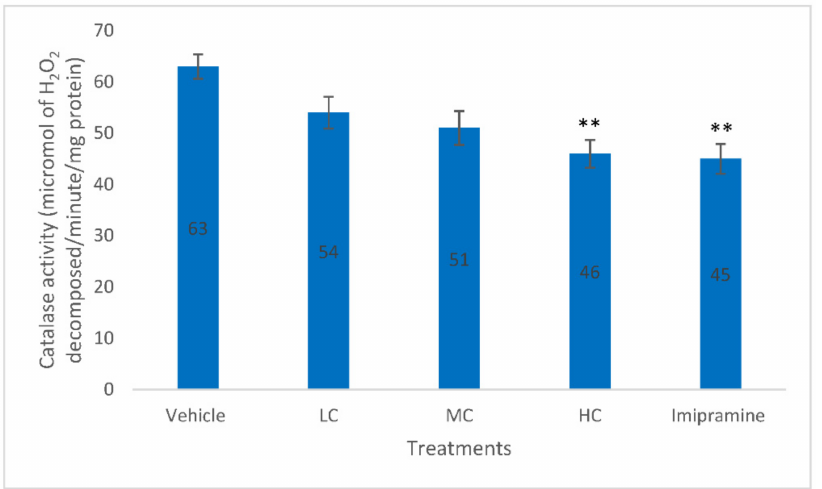
Figure 6. The changes on brain catalase activity due to crocin and imipramine. Data were given as mean and standard error of mean. Each group had eight animals. Statistical analysis was performed by one-way analysis of variance (ANOVA) and post-ANOVA Tukey’s test; ** p < 0.01 when compared to vehicle; LC—low dose of crocin; MC—medium dose of crocin; HC—high dose of crocin. 2.7. The Effect of Crocin and Imipramine on Brain Glutathione (GSH) Level Administration of animals with a medium dose of crocin ( p < 0.01), high dose of crocin ( p < 0.001) and standard antidepressant, imipramine ( p < 0.001) produced significantly elevated brain SGH levels compared to vehicle-treated animals (Figure 7). The best increase in brain SGH level was found with a high dose of crocin, rather than standard imipramine.